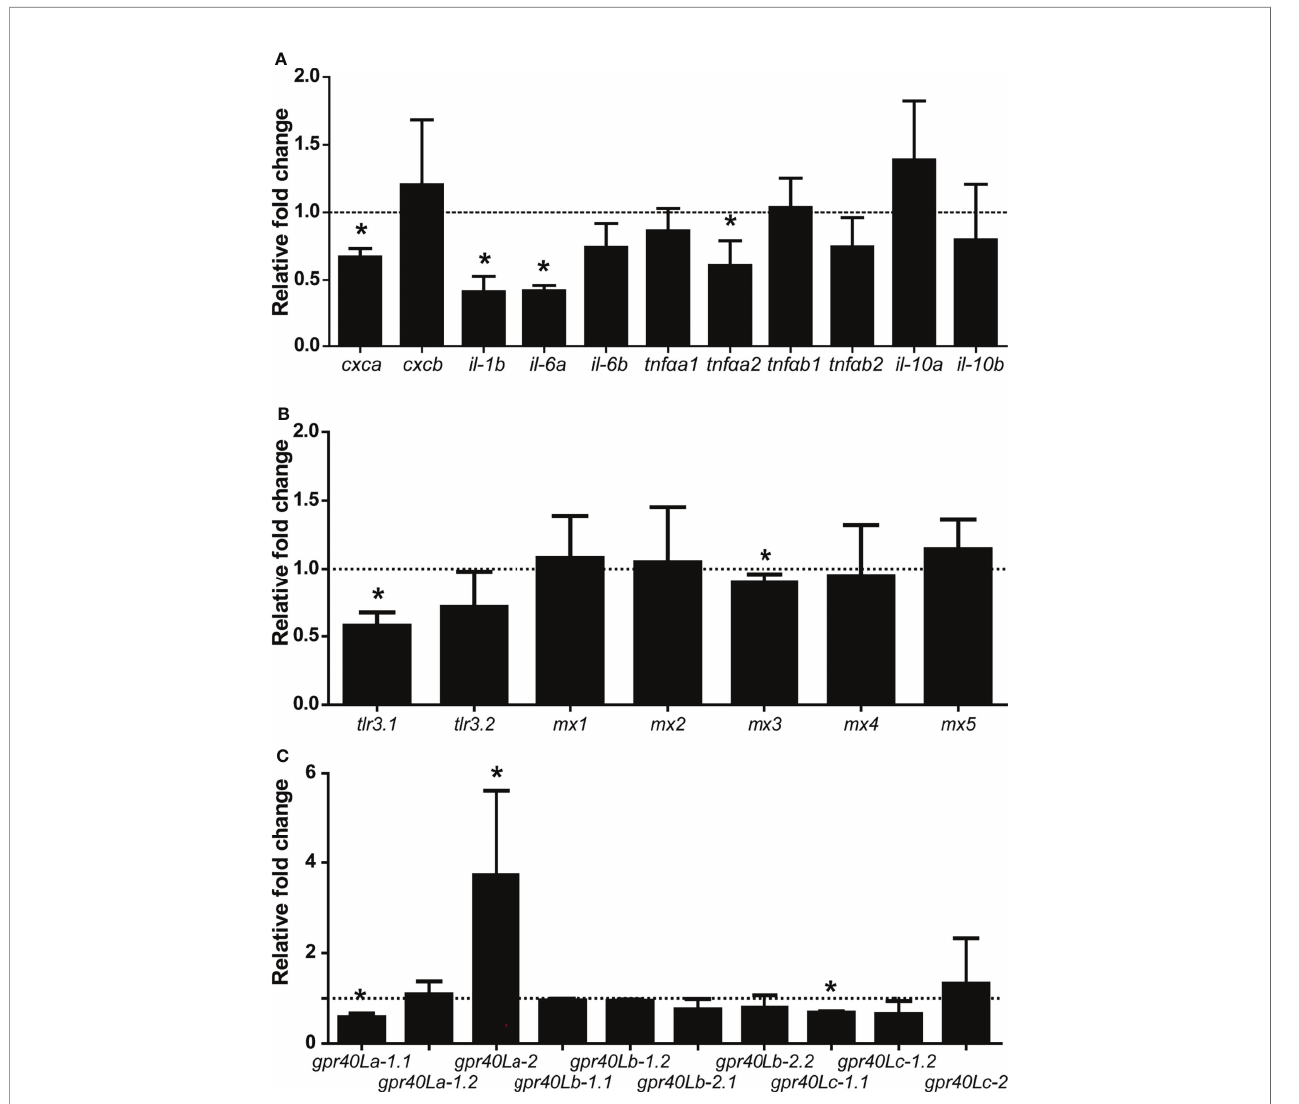
FIGURE 8 | Oral gavage with b -glucans alters cytokine and gpr40L gene expression in the posterior intestine of carp. Gene expression of selected cytokines (A) , Type I IFN-related genes (B) , and gpr40L genes (C) in the posterior intestine of carp treated with the b -glucan group compared to the control group (dotted line), as measured by RT-qPCR 7 days post-gavage. (A) Signi fi cantly lower expressions of cxca , il-1b , il-6a , and tnf a a2 . A trend toward a lower expression of il-6b ( p = 0.062) and tnf a b2 ( p = 0.090) could be observed in the treated group. (B) Signi fi cantly lower expressions of tlr3.1 and mx3 (C) Signi fi cantly lower expressions of gpr40La-1.1 and gpr40Lc-1.1 , but signi fi cantly higher expression of gpr40La-2 . Bars indicate mean ± SD of n = 5 animals. Asterisk (*) indicates signi fi cant difference in expression between the group orally gavaged with PBS and the group orally gavaged with 1 mg MacroGard ® as assessed by one-way